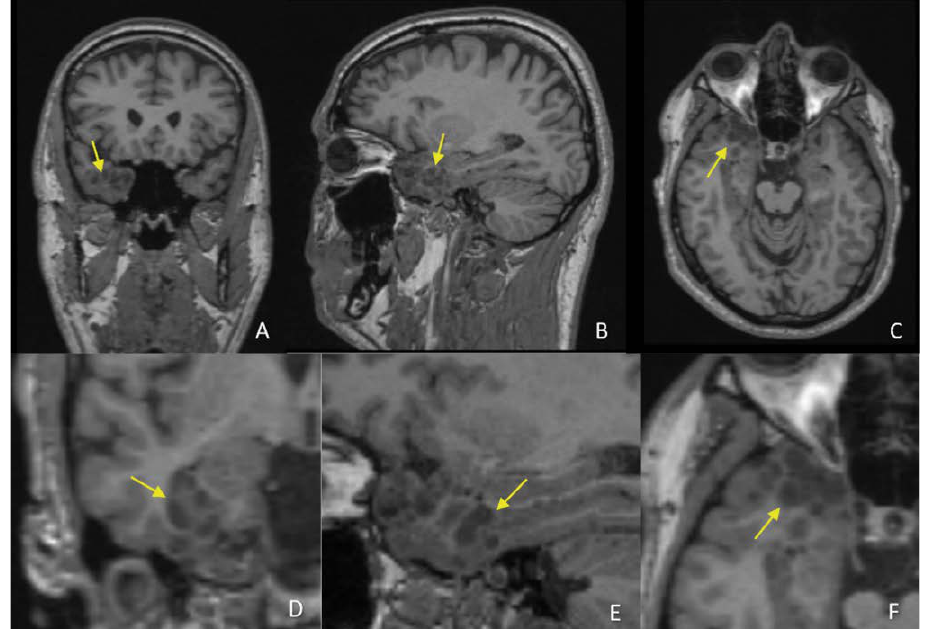
Figure 2. T1wi in coronal ( A ), sagittal ( B ), and axial ( C ) planes with correspondent zoomed images ( D – F ) on the temporal lesion reveal hypointense nodules (yellow arrow) at the cortical–subcortical white matter junction, some of them being clustered together.